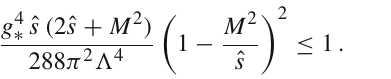
Fig. 4 Bound from (cid:2)ρ in the parameter space ( M ,(cid:5)) for the case of excited lepton triplet with (cid:2) M = 10 GeV, dot-dashed lines (black) and (cid:2) M = 15 GeV, dot-dashed lines (brown). The excluded area with M > (cid:5) is shown in dark grey. The other curves and shadings are as in Fig. 3 the space above the excluded area with M > (cid:5) (shaded in dark grey) is constrained by (cid:2)ρ for mass splittings larger than 5 GeV. Here the space above the bounds are more stringent compared to unitarity bounds even for (cid:2) M = 10 GeV as indicated by the dot-dash black line. Increasing the mass splitting between the triplets to (cid:2) M = 15 GeV result in the exclusion of larger area in the lower right region (area below the lower brown line) as well as the upper left corner of the plot (area above the upper dot-dash brown